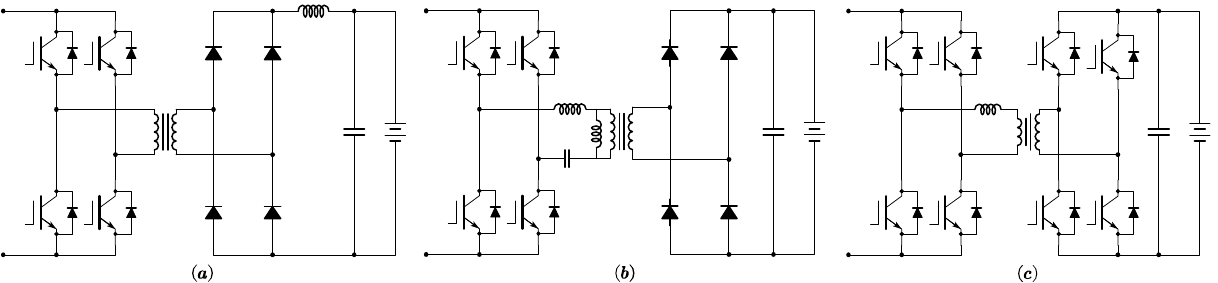
Figure 8. Isolated DC-DC converter configurations for electric vehicle ultra-fast charging application: ( a ) Phase-Shift Full Bridge (PSFB) converter; ( b ) LLC resonant converter; ( c ) Dual Active Bridge (DAB) converter.